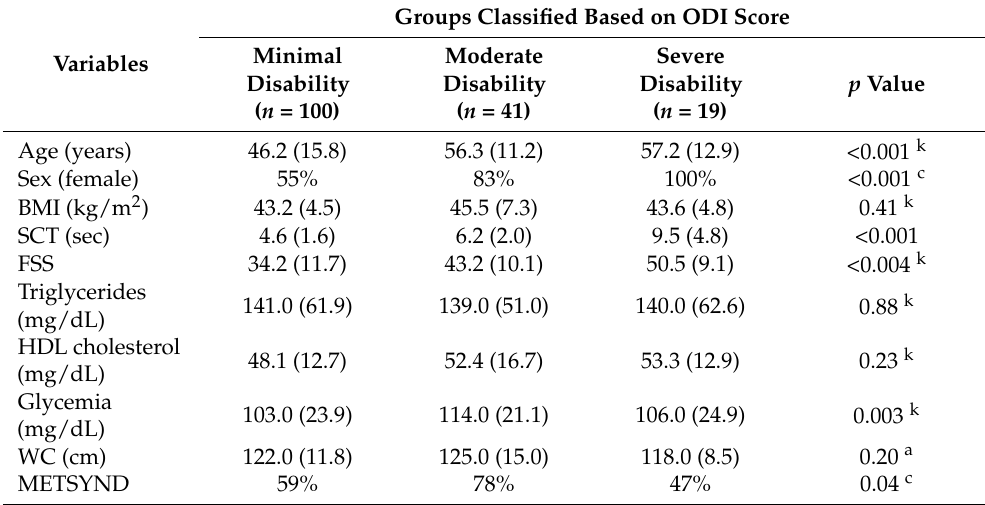
Table 2. Participants’ characteristics by disability groups at baseline (mean ±